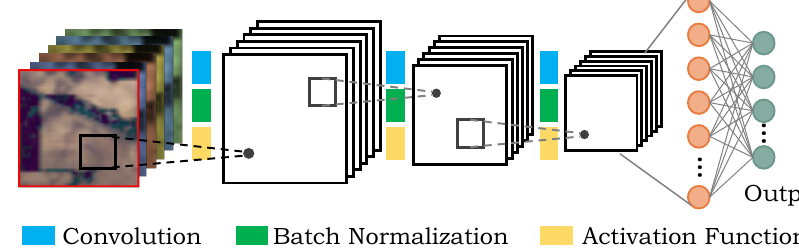
Figure 1. Illustration of CNN structure using convolution